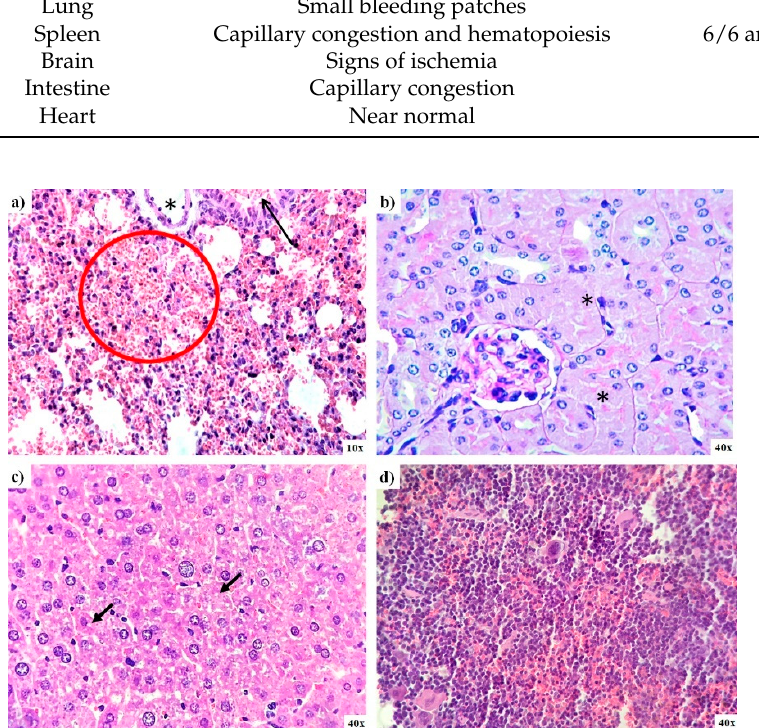
Figure 6. Lung, kidney, liver, and spleen pathology analysis of mice exposed to AgNPs from lethal dose determination. ( a ) Small bleeding patches (red circle) and bronchiolar lumen (black arrow) found in the lung; ( b ) necrosis found in kidney tubules (asterisk); ( c ) evidence of microvesicular steatosis in the liver (black arrows), and ( d ) spleen tissue that exhibits light signs of congestion.